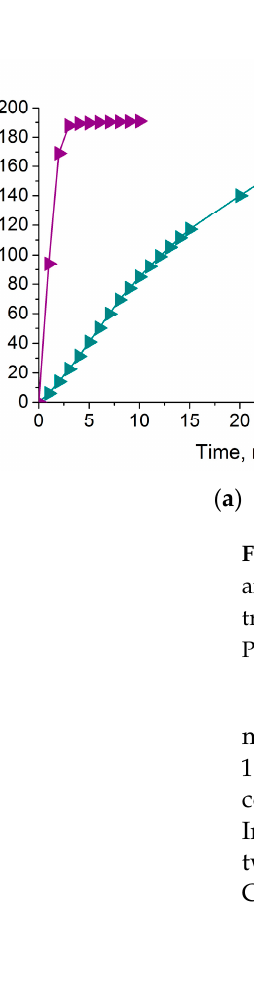
matographic analysis, the maximum yield of 3,7,11-trimethyldodecen-1-ol-3 (C 15 -en) on 1%Pd-PVP/ZnO was observed at the first minute of the reaction and was 90.4%, which In the case of the 1%Pd/ZnO catalyst, the maximum yield of C 15 -en was obtained at the twelfth minute and was 81.8%, which corresponds to the 91% selectivity for C 15 -en at the C 15 -yn conversion of 90.0% (Figure 8b).